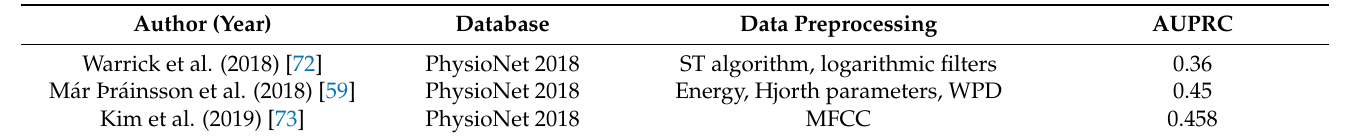
Table 6. Comparison of LSTM-based